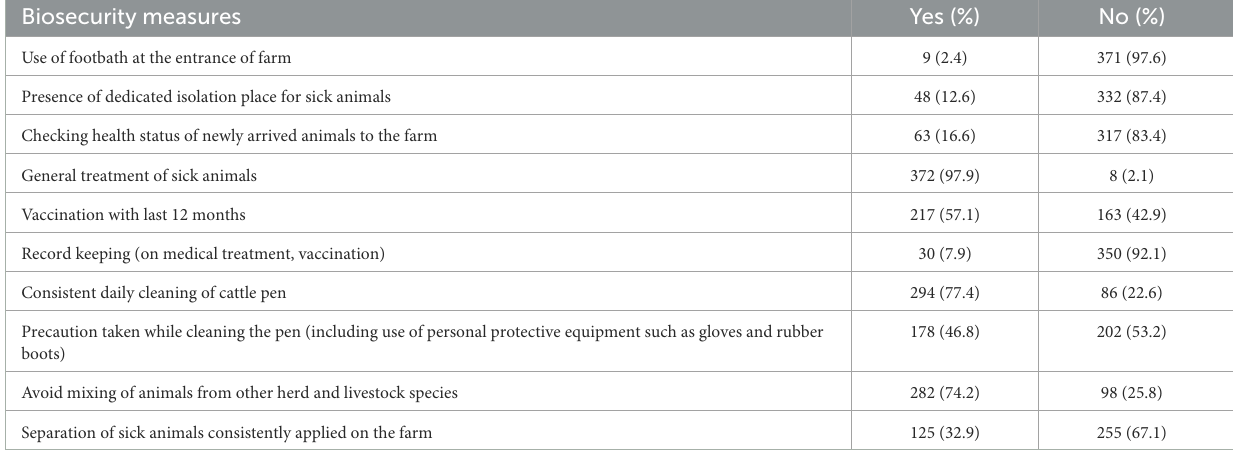
TABLE 4 Biosecurity measures taken at different dairy farms in central Ethiopia ( n = 380).